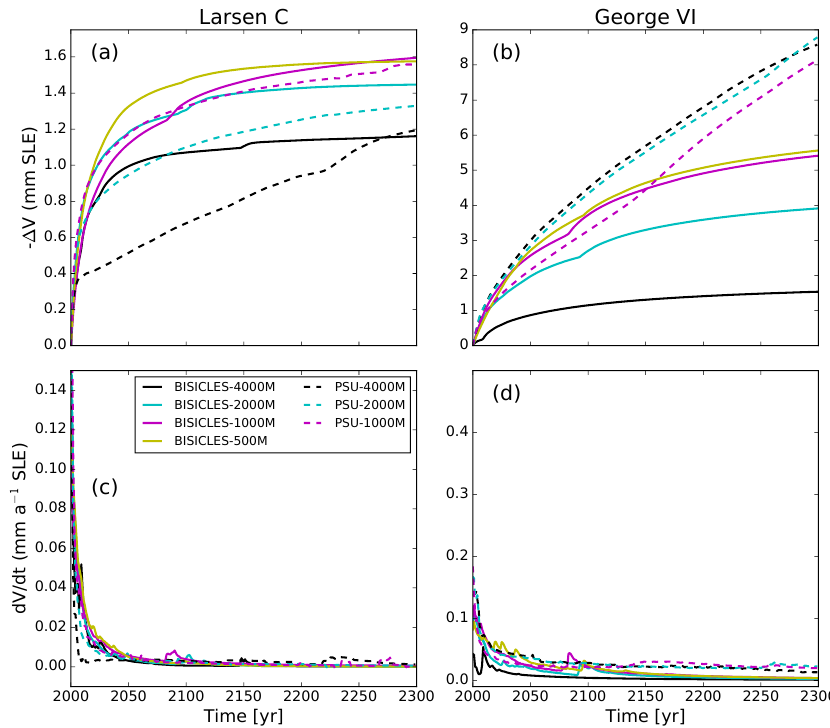
Figure A6. Upper panels (a, b) show sea-level rise projections from Experiment 1 (immediate shelf collapse) at different horizontal resolu- tions for BISICLES (solid lines) and PSU3D (dashed lines). Lower panels (c, d) show the derivative (rate of change) of the corresponding sea-level rise projections in the upper panels (a, b) . Note the different y axis